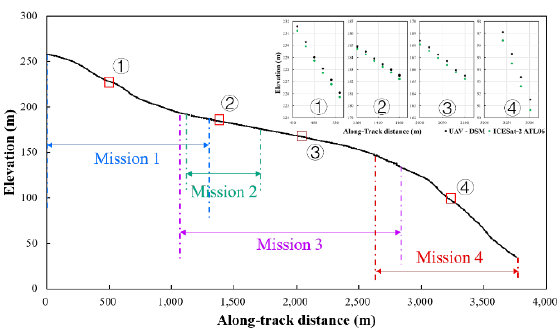
Figure 6 . Elevation profile in study area along ICESat-2 track and the variable vertical offsets between DSM and ICESat-2.